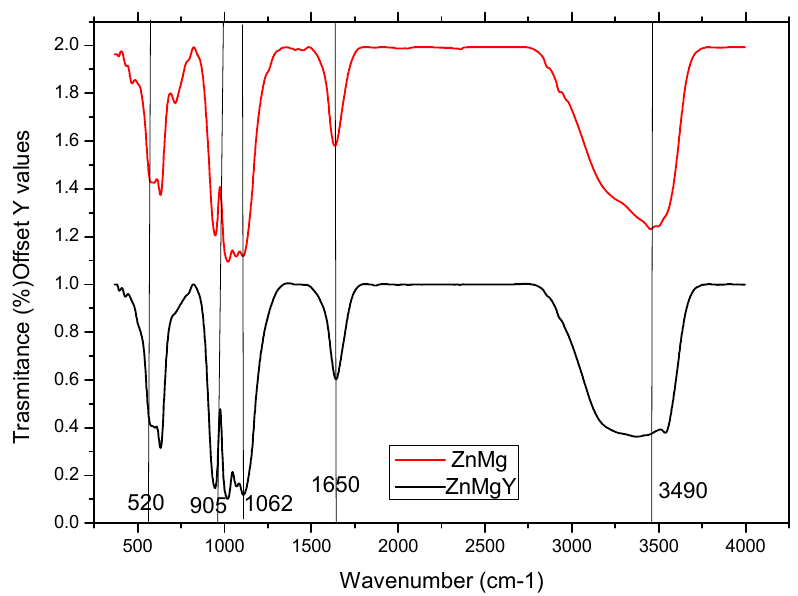
Figure 6. FTIR spectra of the corrosion compounds from ZnMg and ZnMgY samples after immersion in SBF solution. The vertical line explaine the exact values of the peaks.